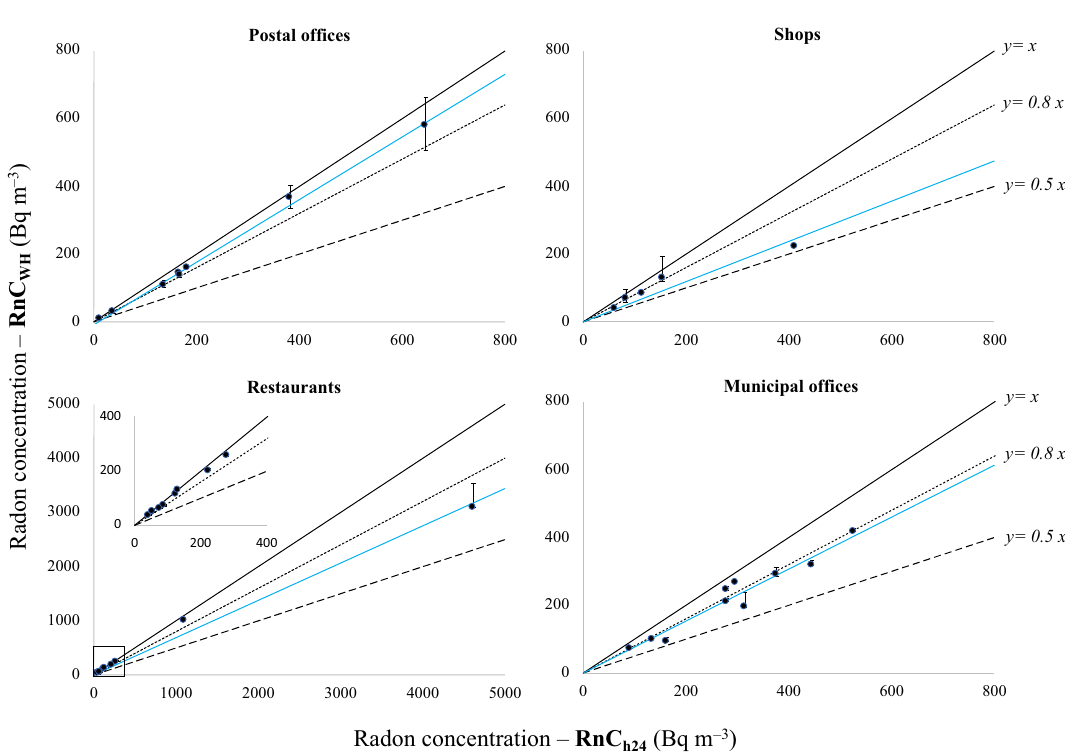
Figure 3. Comparison between average radon concentrations, over the all the days and hours (RnC H24 ) and over the working hours (RnC WH ) only, for the first 6-month period of exposure. The full lines represent the bisecting lines. The dotted and dashed lines represent lines with slopes of 0.8 and 0.5, respectively. The best fit lines are in blue. As y error bars are reported the maximum differences with RnC WH (reported in Table 3) estimated varying of 1–2 h the actual working hours. The smaller plot in the restaurants box is a zoom in the range 0–400 Bq m –3